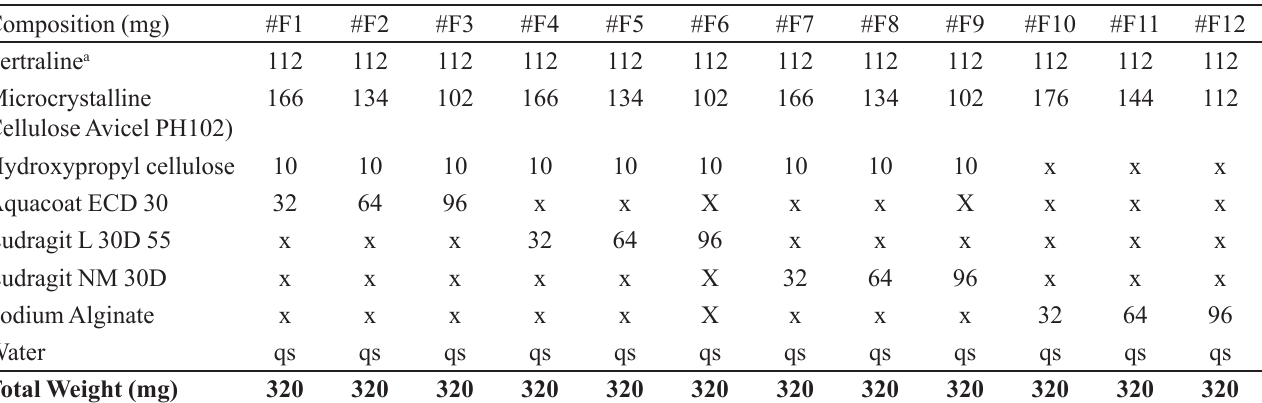
TABLE I - Composition of extended release matrix pellets using various polymers Composition